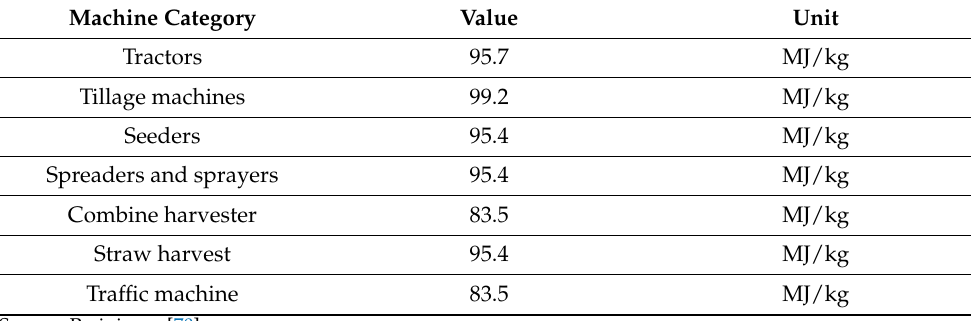
Table A3. Conversion factors for calculating the energy contained in machines.